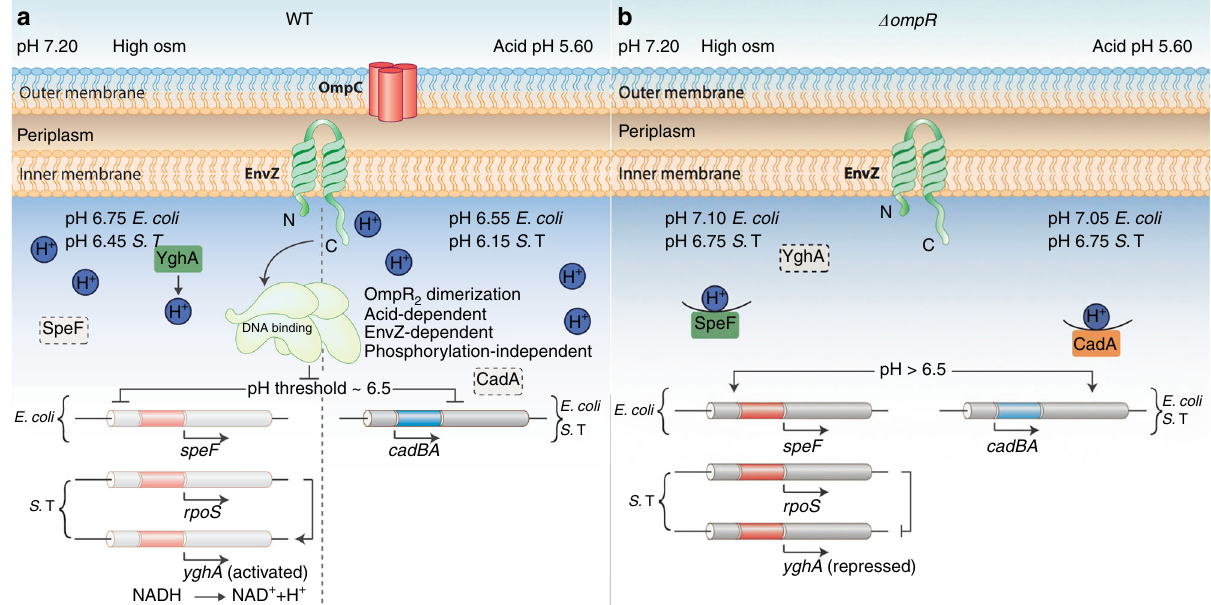
Fig. 7 Model for OmpR-driven acidi fi cation in response to acid and osmotic stress. Under acid and osmotic stress conditions, both S . Typhimurium and E. coli are acidi fi ed in an OmpR-dependent manner. OmpR requires interaction with EnvZ, but not phosphorylation to bring about cytoplasmic acidi fi cation. a In wild-type bacteria, under acid stress, OmpR represses the cad operon to eliminate proton consumption, resulting in acidi fi cation. At high osmolality,